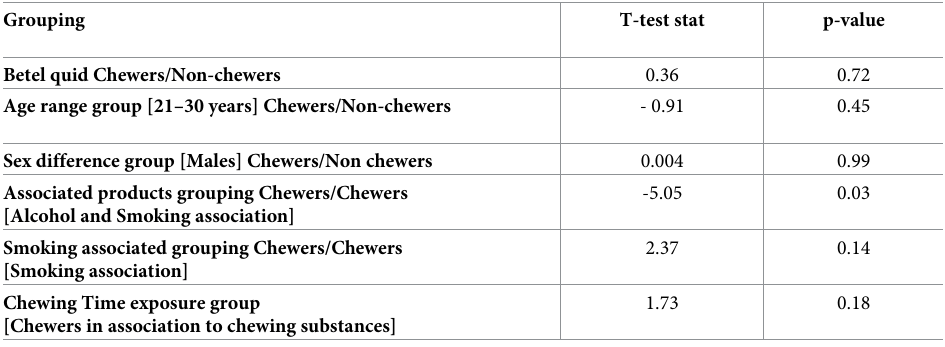
Table 2. Alpha diversity (comparison